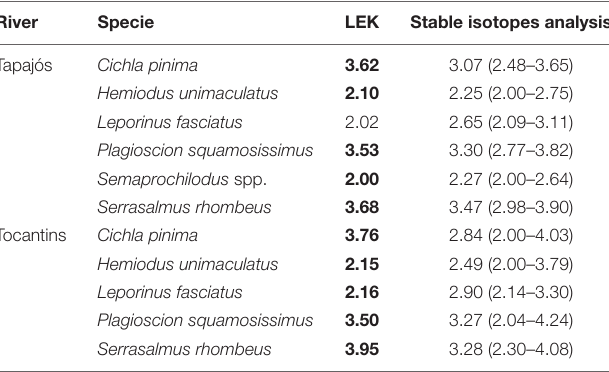
TABLE 2 | Trophic levels calculated from the local ecological knowledge (LEK) of fishers and posterior trophic level estimates originated from Bayesian models (mean values and 95% credibility interval) based on stable isotopes analysis for the fish species studied in the Tapajós and Tocantins